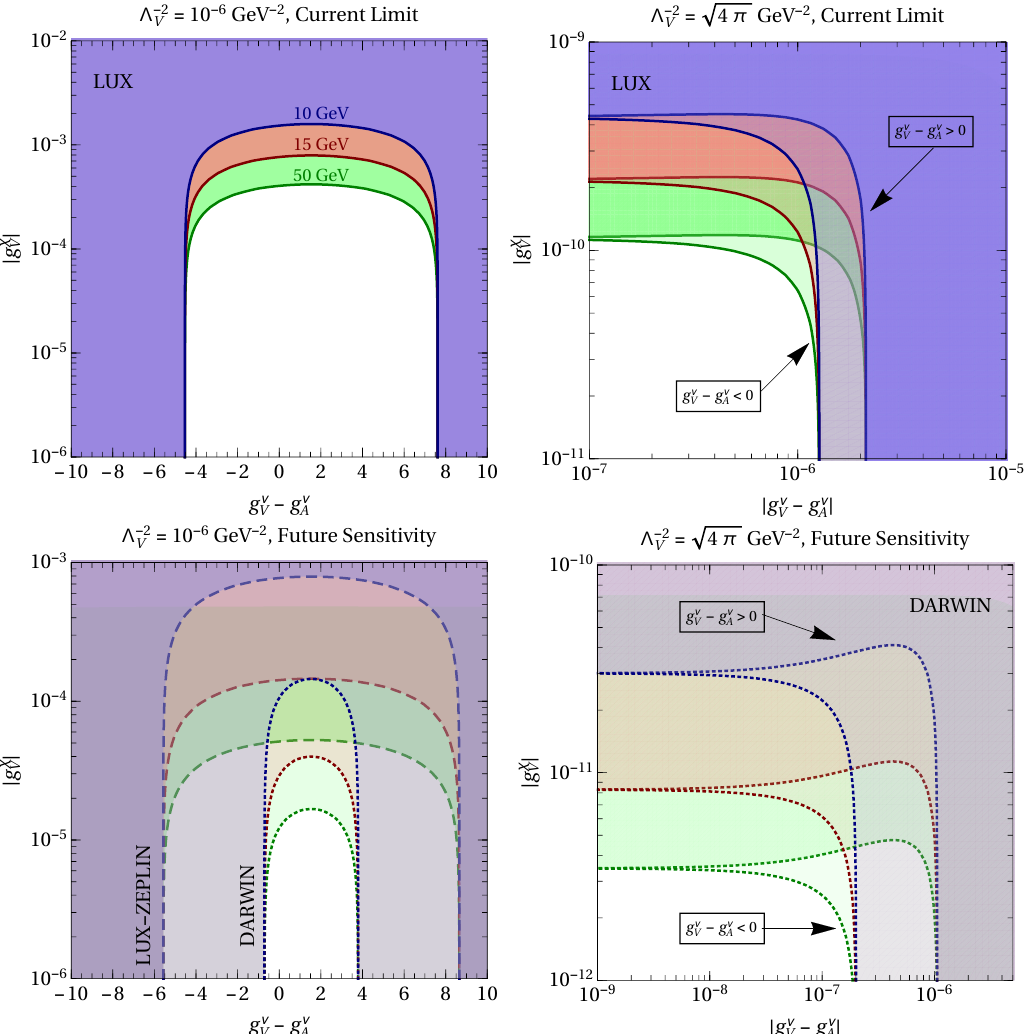
Figure 2 . Current limits (top panels) and future sensitivity (bottom panels) on the parameters of the vector model. The coloured region can be excluded at 90% C.L. by current LUX data [44] (continuous lines) and by the future LUX-ZEPLIN [42] (dashed lines) and DARWIN [43] experi- ments (dotted lines). The plots are for m (cid:31) = 10 GeV (violet), 15 GeV (red) and 50 GeV (green) p for two di(cid:11)erent cases: (cid:3) (cid:0) 2 = 10 (cid:0) 6 GeV (cid:0) 2 (left) and (cid:3) (cid:0) 2 = 4 (cid:25) GeV (cid:0) 2 (right). For V V